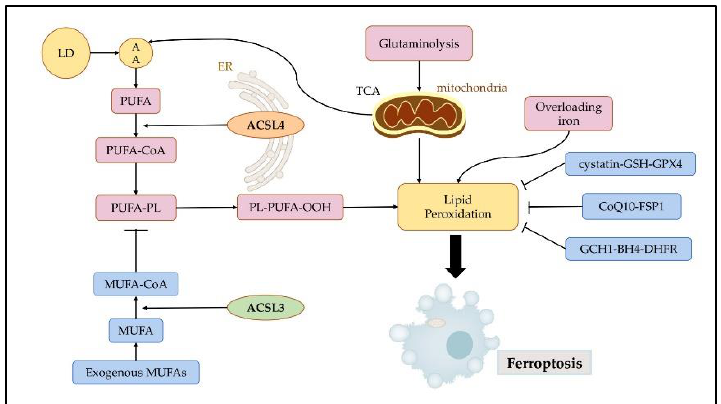
Figure 3. Regulatory mechanisms of ferroptosis. Ferroptosis is mainly initiated by excessive produc- tion and failure to eliminate iron, lipid peroxidation, and subsequent plasma membrane rupture. Ferroptosis is induced by lipid peroxidation. ACSL4 contributes to the synthesis of high levels of PUFAs, which promote ferroptosis. ACSL3 is key to MUFA-induced ferroptosis resistance. Three pathways, namely the cystatin-GSH-GPX4, CoQ10-FSP1, and GCH1-BH4-DHFR axis can effectively resist ferroptosis by inhibiting lipid peroxidation. LDs: lipid droplets; AA: arachidonic acid; PUFA: polyunsaturated fatty acids; MUFA: monounsaturated fatty acids; ER: endoplasmic reticulum; TCA: tricarboxylic acid